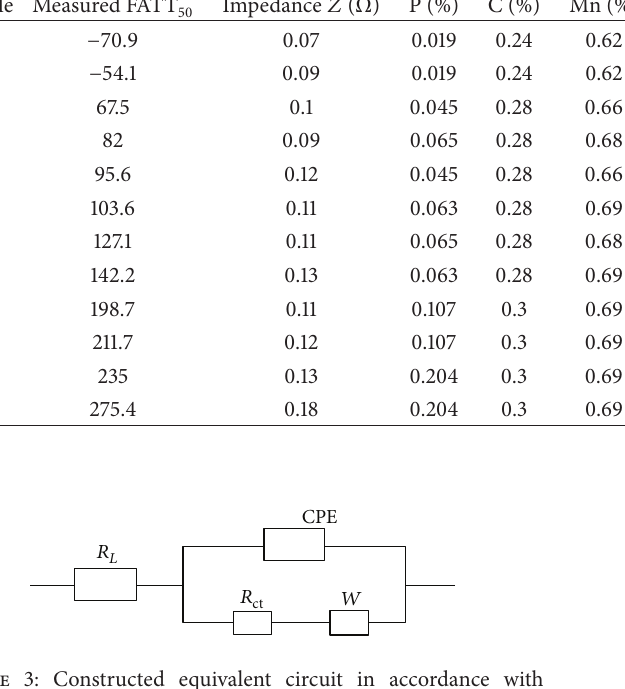
Figure 3: Constructed equivalent circuit in accordance with Figure 1.